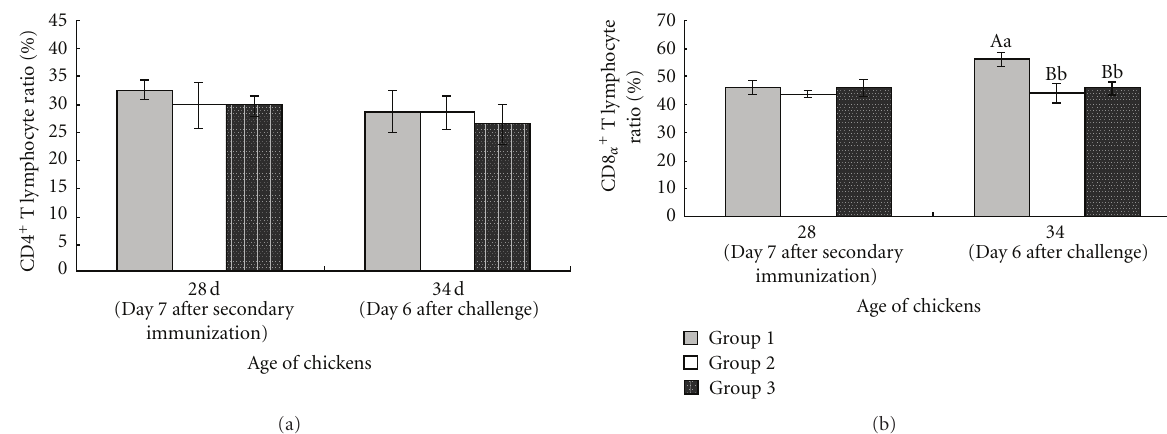
Figure 2: Flow cytometric analysis of CD4 + and CD8 α + cells isolated from splenocytes of chickens. Chickens in each group were, respectively, intramuscularly immunized with 100 μ g pcDNA-3-1E-linker-mChIL-15 (group 1), 100 μ g pcDNA3.1 (group 2), and sterile TE bu ff er (pH 7.6) (group 3) at 14 and 21 days of age. All chickens were inoculated orally with 5 × 10 4 sporulated oocysts of E. acervulina at 28 days of age (day 7 after secondary immunization). The ratio of CD4 + and CD8 α + cells in spleen of randomly selected five chickens was assayed at 28 and 34 days of age (day 6 after challenge). Data represent mean ± standard errors ( n = 5 per group). Highly significant di ff erence ( P < 0 . 01) between bars not sharing the same capital letters in each time point. Significant di ff erence ( P < 0 . 05) between bars not sharing the same small letters in each time point.